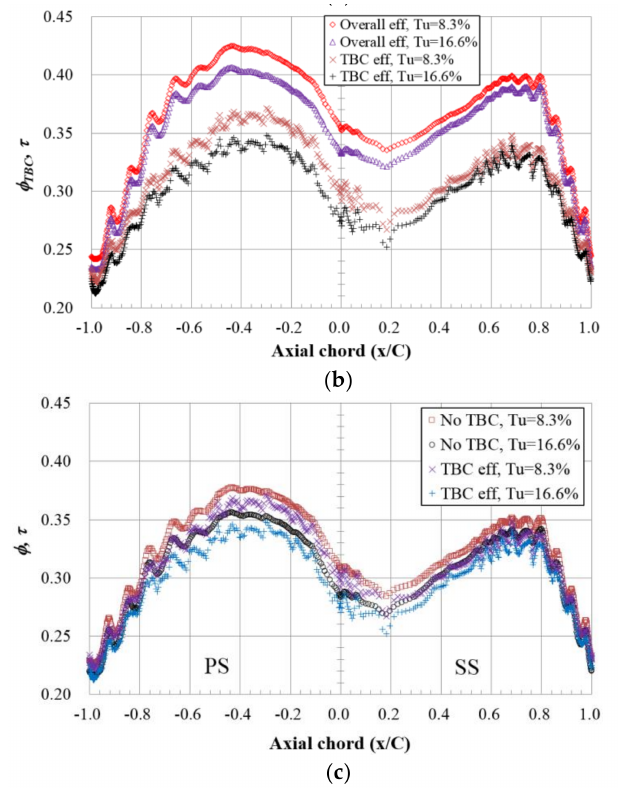
Figure 9. Effects of Tu and TBC on ϕ , ϕ TBC , and τ distributions at midspan in comparisons between (a) ϕ and ϕ TBC , (b) ϕ TBC and τ , and (c) ϕ and τ .